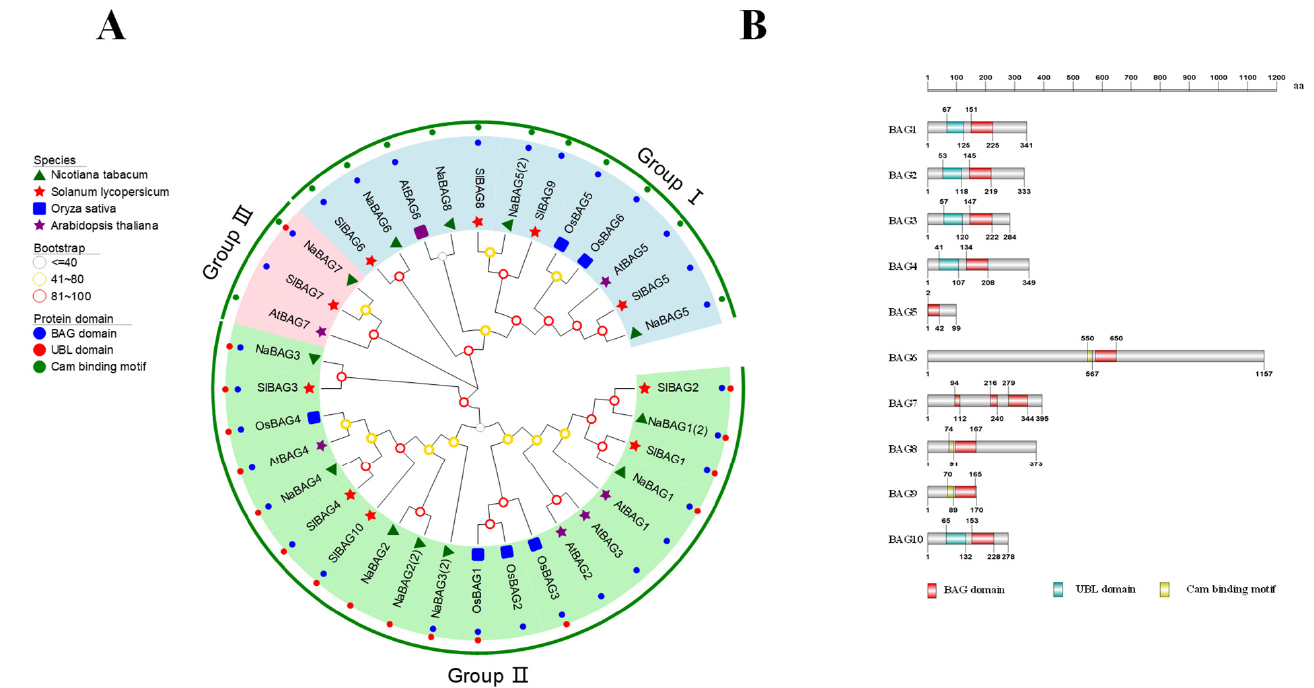
Figure 1. Phylogenetic tree construction of BAGs from different plants and protein structures of BAGs. ( A ) Phylogenetic tree of BAG proteins. The different colored circles on the outside of the protein names represented the types of structural domains possessed by amino-acid sequences (blue for BAG domains, red for UBL domains, and green for calmodulin-binding (CaM) motifs). The symbols on the inside of the protein names represented different species (purple stars for Arabidopsis thaliana , green triangles for Nicotiana tabacum , blue squares for Oryza sativa , and red stars for Solanum lycopersicum ). ( B ) Schematic diagram of the domains of BAG proteins in tomato. The protein lengths were shown in grey.